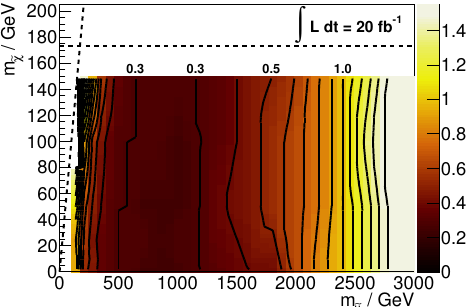
Figure 2 . The median value of f (in e(cid:11)ect the expected sensitivity of the method) for the grid of (cid:21) 0 = 1 signal models. Contour lines 231 show integer values of sensitivity.